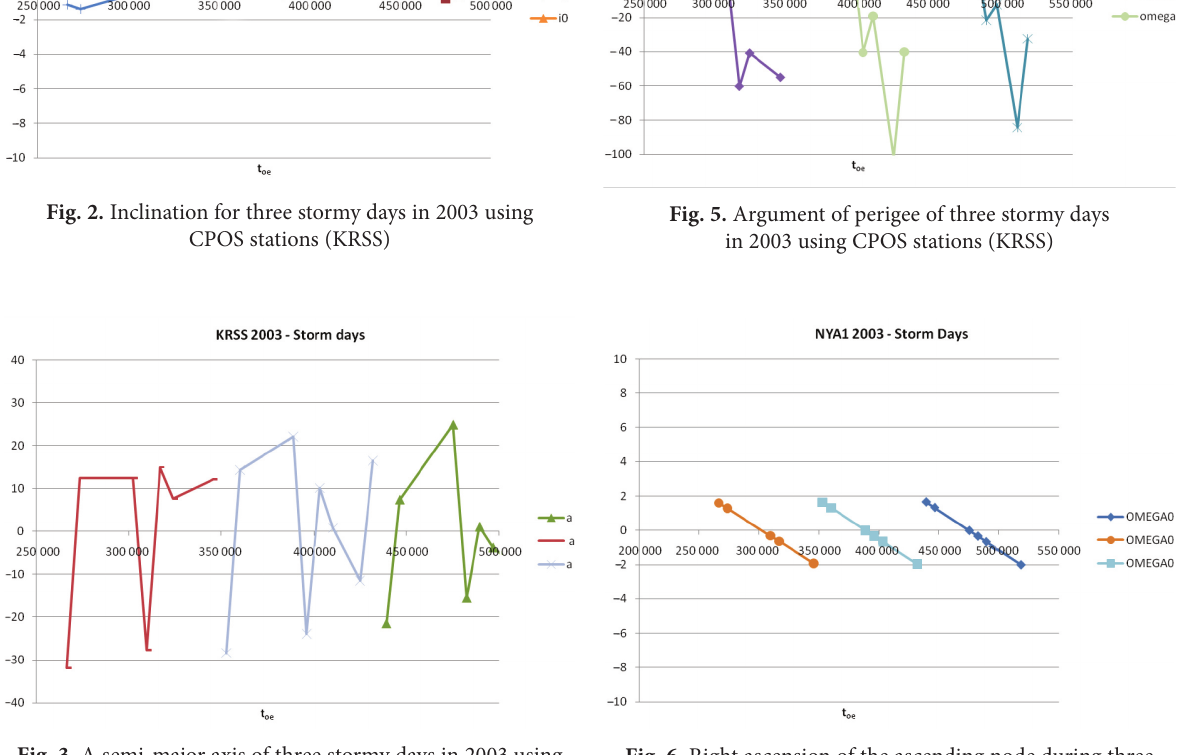
Fig. 6. Right ascension of the ascending node during three stormy days in 2003 using cPOS stations (NYa1)